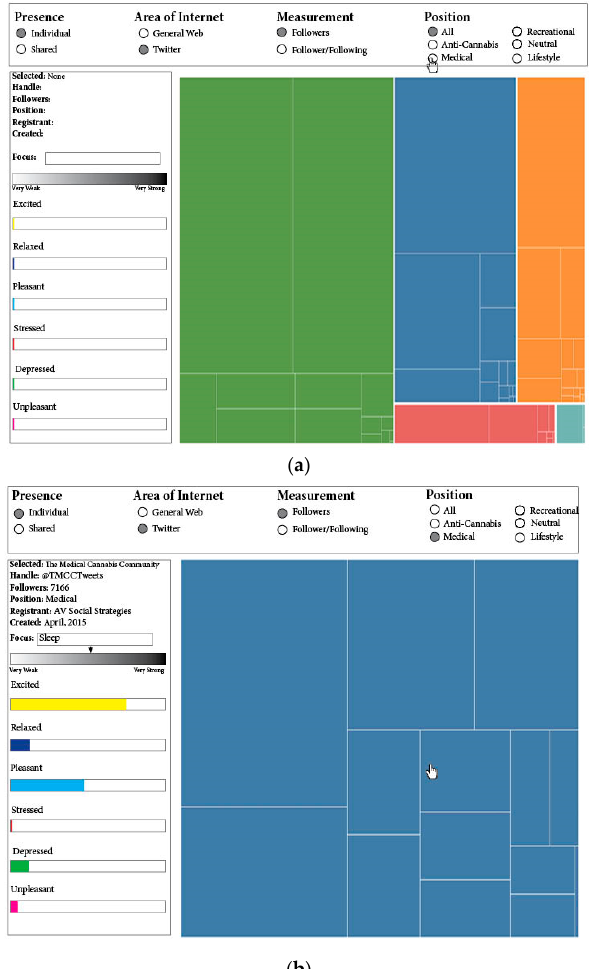
Figure 11. ( a ). VAS for Cannabis. ( b ). VAS for Cannabis with selections